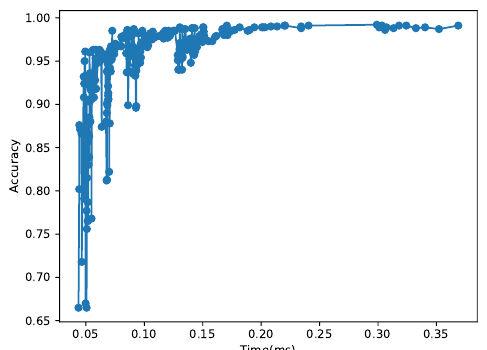
Figure 12. Time vs. Accuracy for the MNIST Data Set. As plotted in this figure, there are many CNN models that are Pareto suboptimal; that is, their accuracy is lower than that supported by one or more CNNs with shorter execution times. Our approach eliminates them to support adaptive real-time image classification cost-efficiently.